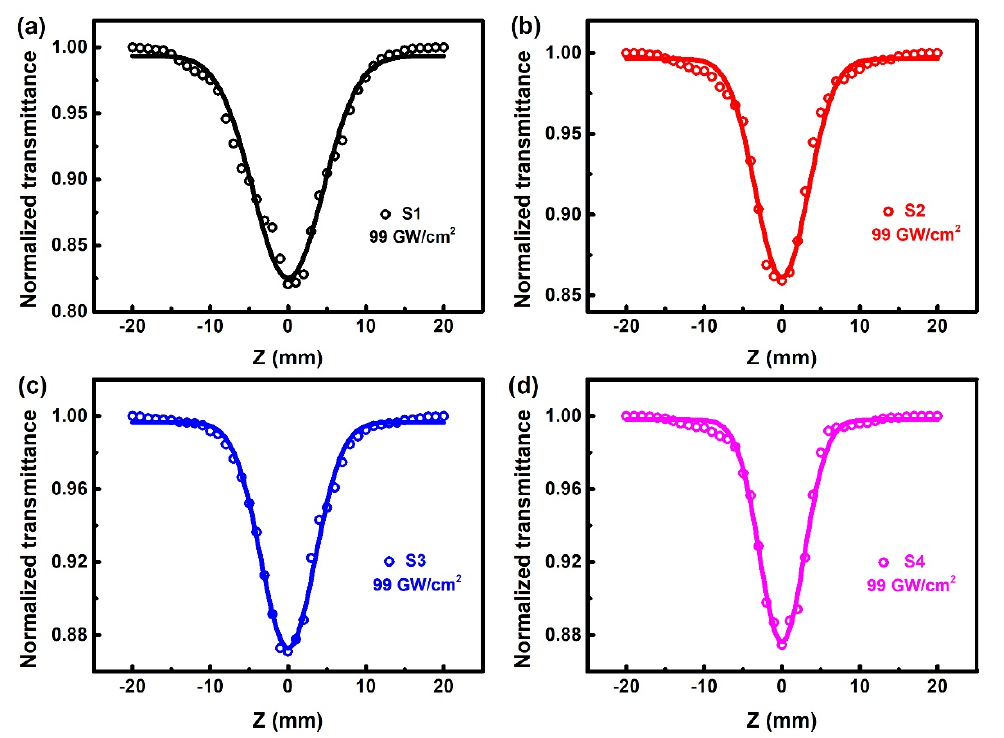
Figure 8. The open-aperture (OA) Z-scan curves of Ta-doped InTe thin films ( a ) S1, ( b ) S2, ( c ) S3, ( d ) S4 at the excitation of 800 nm wavelength.